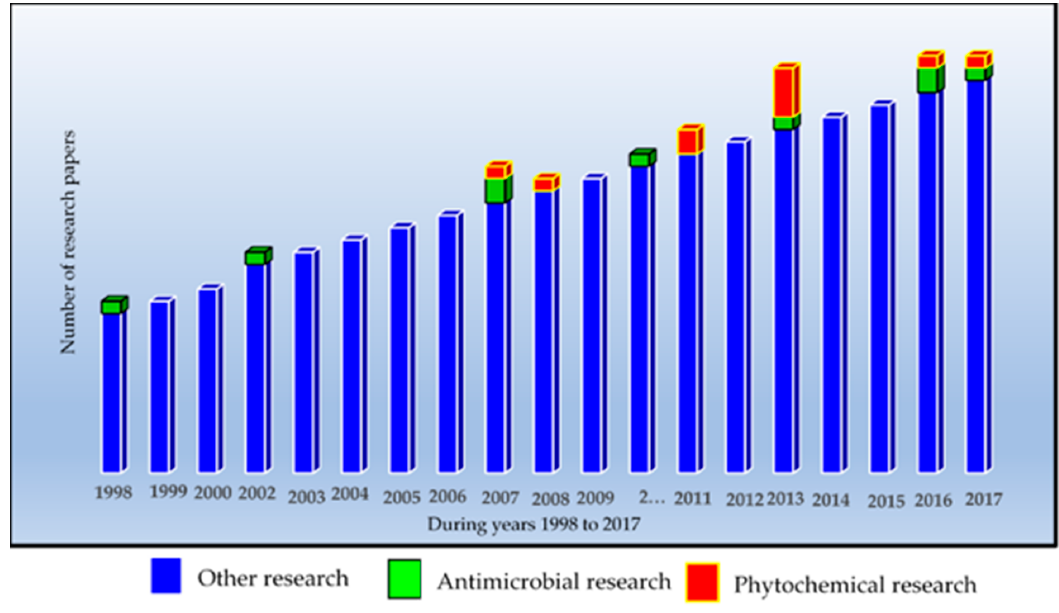
Figure 2. Trend in the number of research papers on Anogeissus leiocarpa from 1998 to 2017. The figure illustrates that most of the research papers have dealt with other research aspects than antimicrobial or phytochemical research. Thus, there is a need for more research in the mentioned research areas. Source: Scopus research data base.